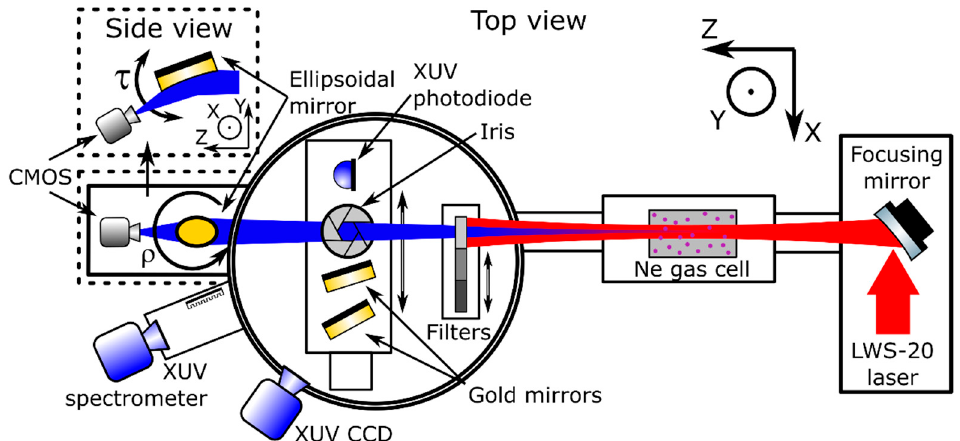
Figure 1. Experimental setup. The pulses from the LWS-20 laser system are focused with an f = 22 m mirror into a neon gas cell to generate high-order harmonics. Different XUV and soft-X-ray spectral regions are selected by thin metallic filters on a filter wheel. An XUV photodiode measures the XUV pulse energy, and a motorized iris sets the beam diameter. Gold mirrors can send the beam to an XUV CCD camera to determine the beam profile and to an XUV spectrometer. The ellipsoidal mirror focuses the XUV beam, and the focus is observed with a CMOS camera. X, Y, Z: define the coordinate system as it is used in the article; τ : grazing incidence angle of the ellipsoidal mirror; ρ : azimuth rotation angle of the ellipsoidal mirror. There are two additional flat grazing incidence mirrors in front of the filter wheel that are not included in this illustration.